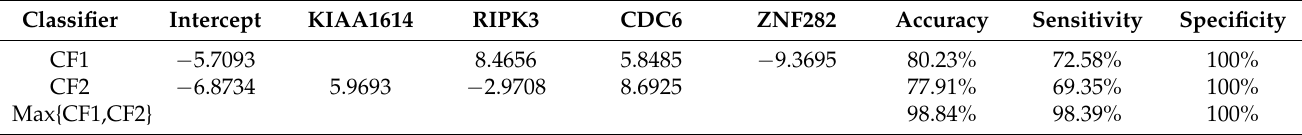
Table 9. GSE152641: Characteristics of the top-performing four-gene classifier. CF1 and CF2 are the first and second individual classifiers for data of COVID-19 patients vs. healthy